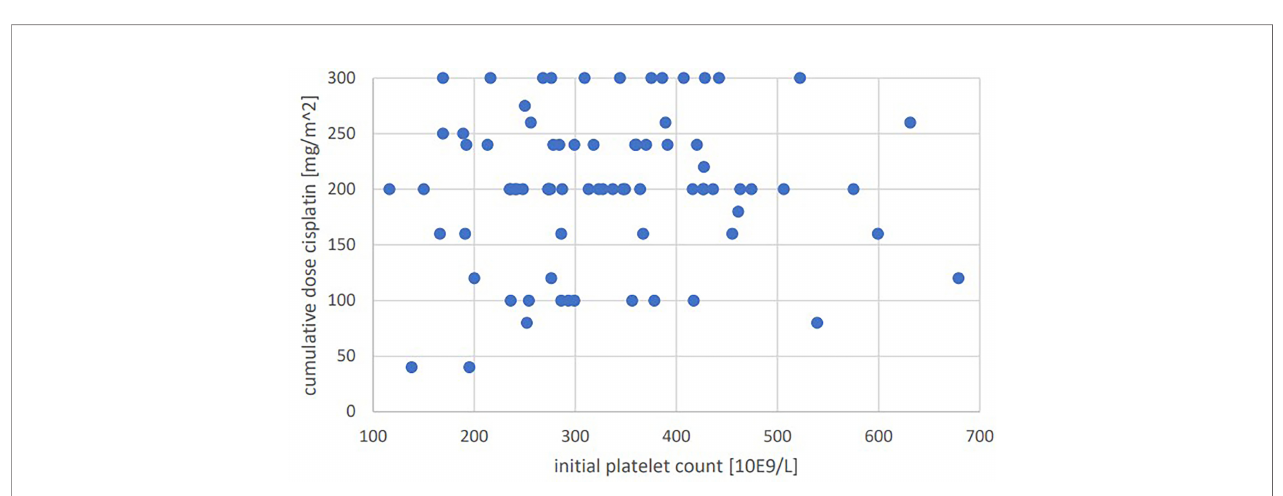
FIGURE 6 | Bivariate correlation analysis of initial platelet count [10E9/L] with fi nal cumulative total dose of cisplatin achieved [mg/m^2]: p=0.56, no signi fi cant correlation; individual values as